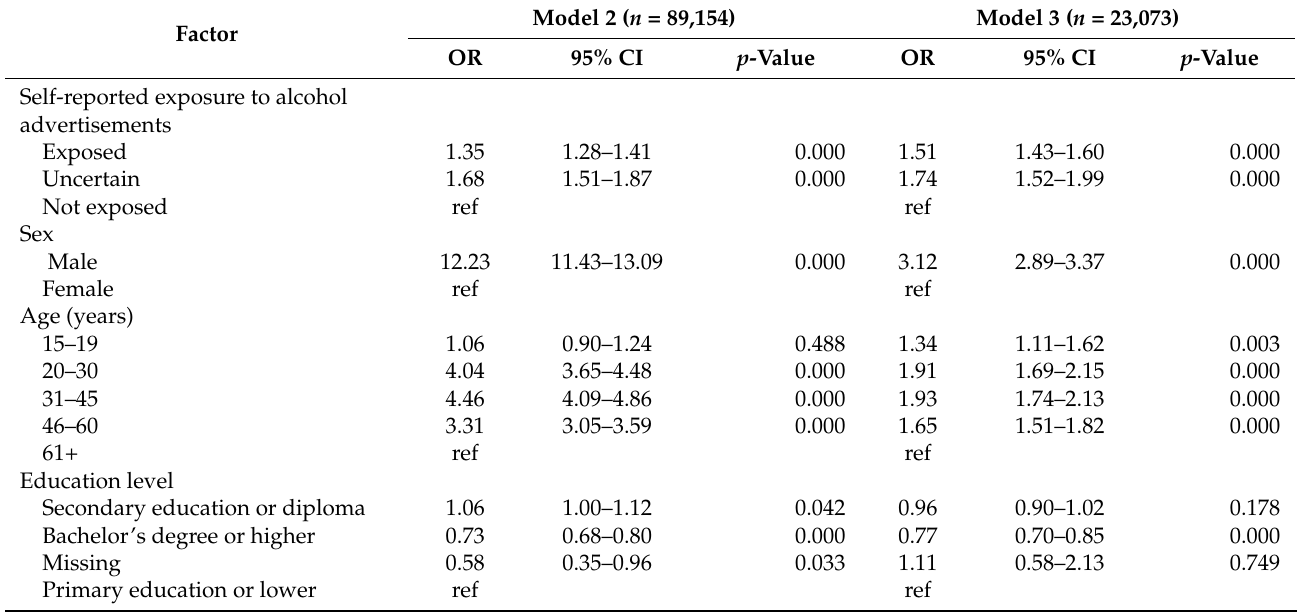
Table 4. Factors associated with past-year heavy